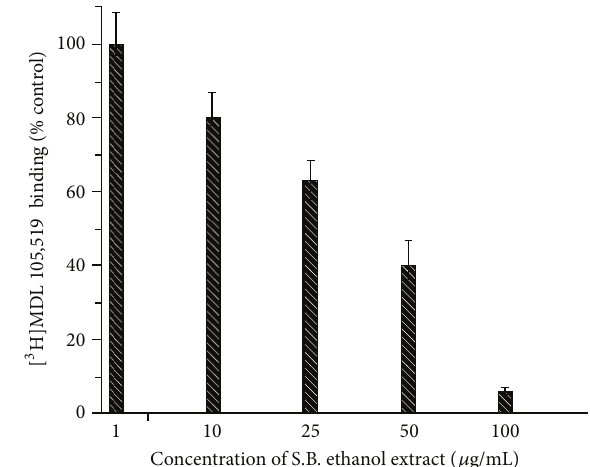
Figure 3: Scutellaria baicalensis (S.B.) extract inhibits the specific binding of [ 3 H]MDL 105,519 to the glycine site of the N-methyl-D- aspartate (NMDA) receptor. Different concentrations of the extract were employed. Nonspecific binding determined in the presence of 2 mM glycine was subtracted from the total binding. Data were calculated as percent of the control binding measured in the absence of the